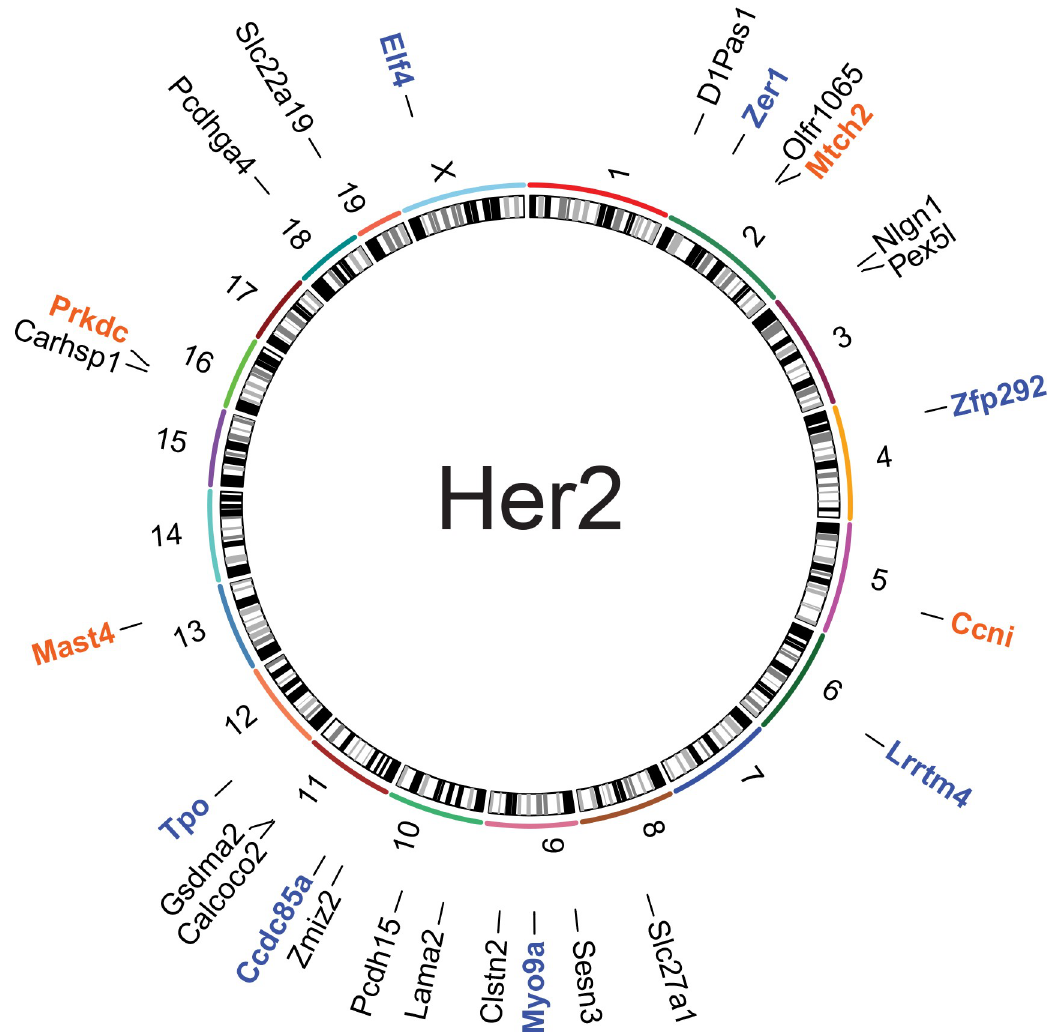
Fig 2. Metastasis-specific SNVs can be found at high allele frequency in the Her2 model. B- Circos plots showing names and chromosomal location of genes identified by exome- and RNA-seq with metastasis-specific SNVs (orange: recurrent single strain, blue: recurrent in both strains, and black: singly mutated) from the Her2